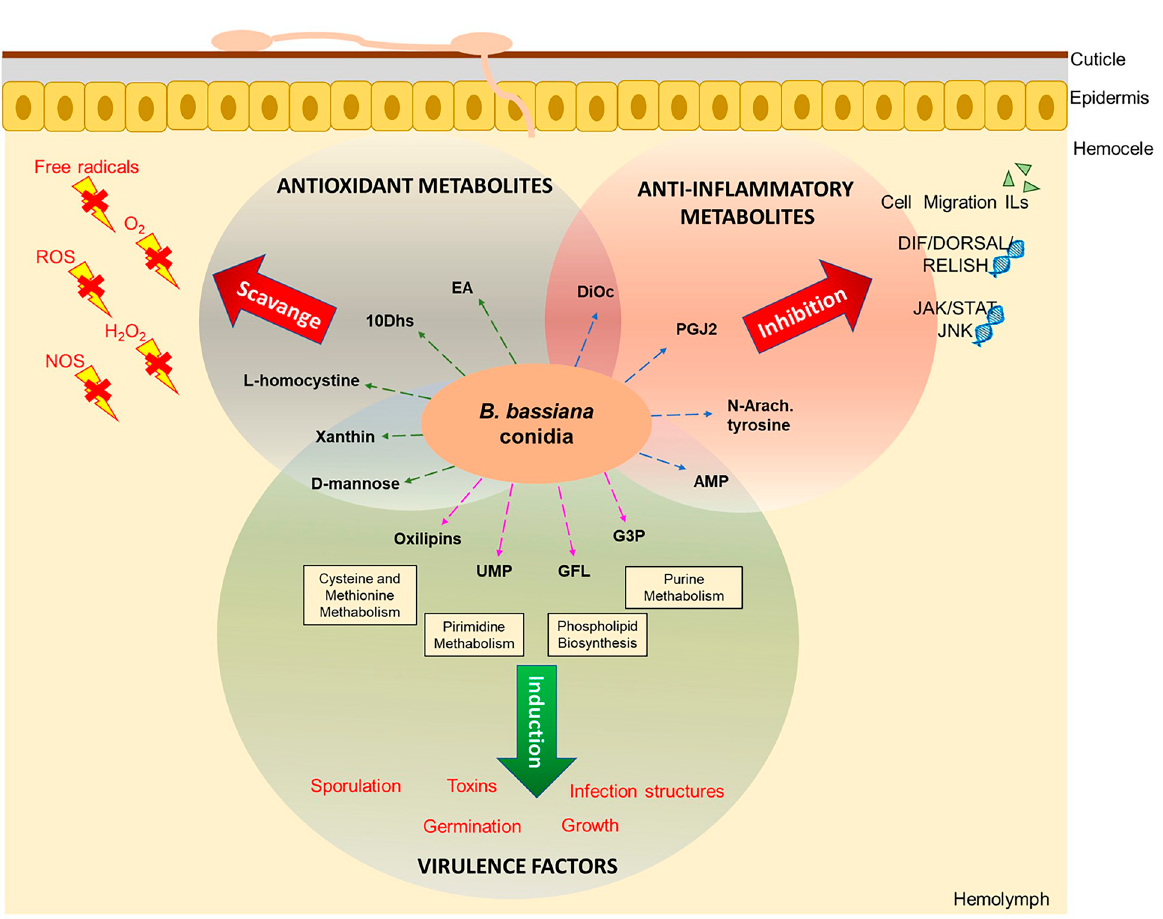
Fig 6. Mode of action hypothesis of the metabolites identified in the consortium on the Duponchelia fovealis immune